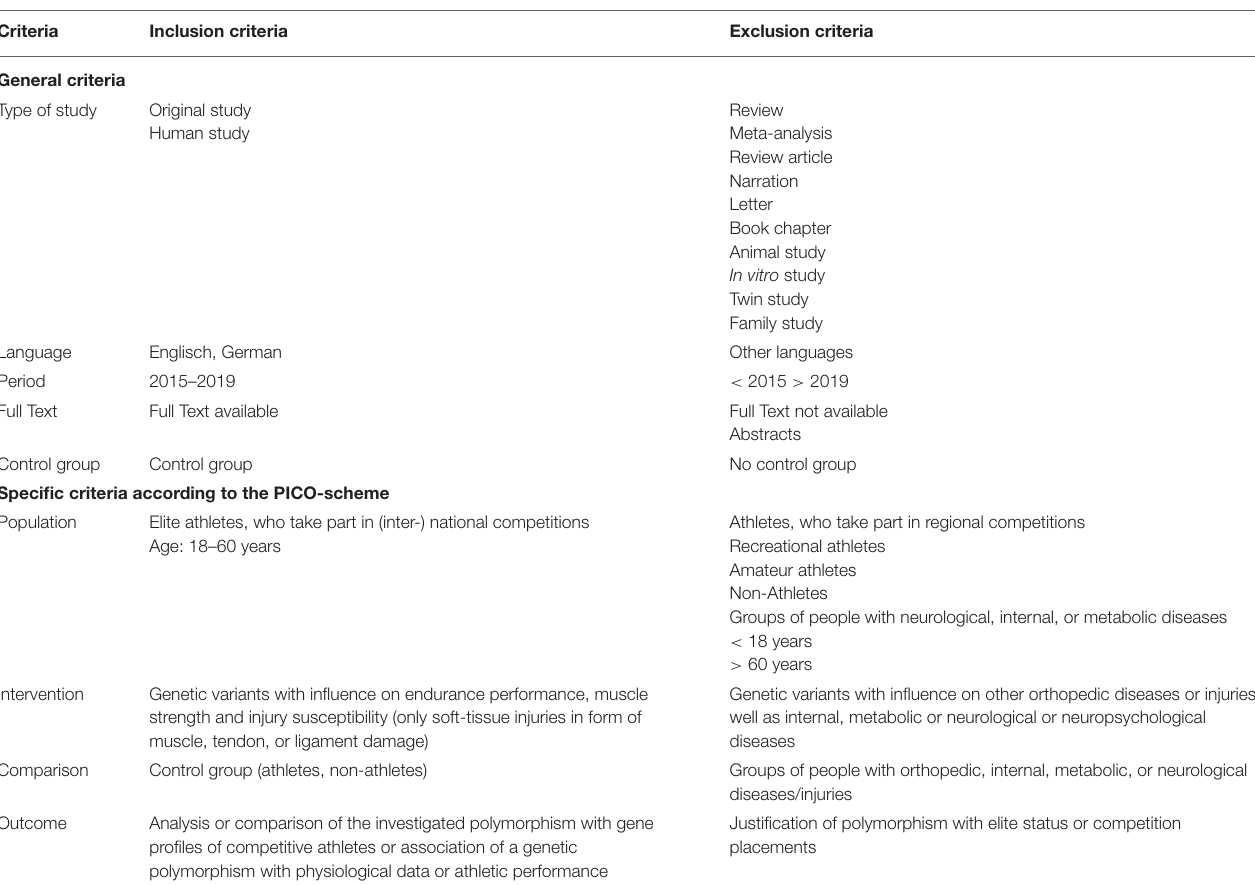
TABLE 2 | Eligibility